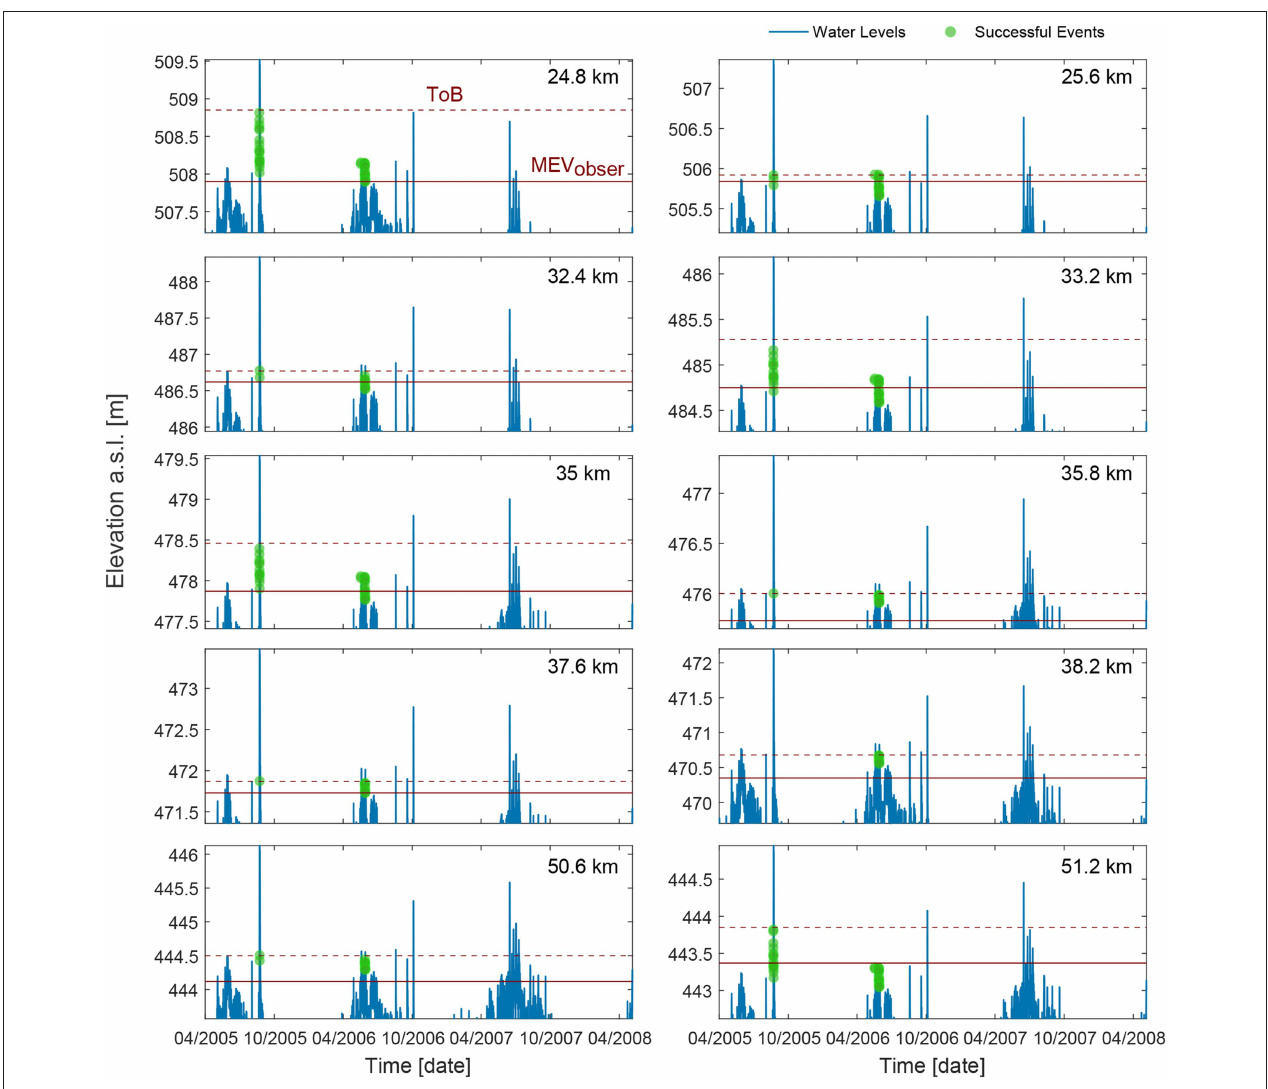
FIGURE 12 | Timing and location of successful recruitment events calculated by the model. Water level for the recruitment period is shown with blue line for each cross section. The minimum elevation where we observed vegetation in 2008 (MEV observ ) is depicted with a solid horizontal line, while the top of the bar (ToB) with a dashed